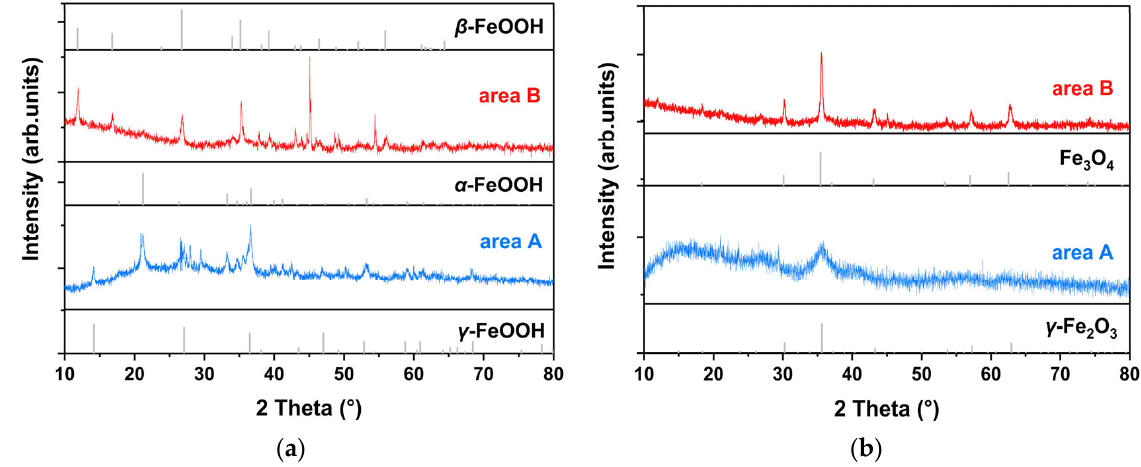
Figure 7. XRD of original rust ( a ) and the modified by proanthocyanidins ( b ). Figure 7 . XRD of original rust ( a ) and the modified by proanthocyanidins ( b ).